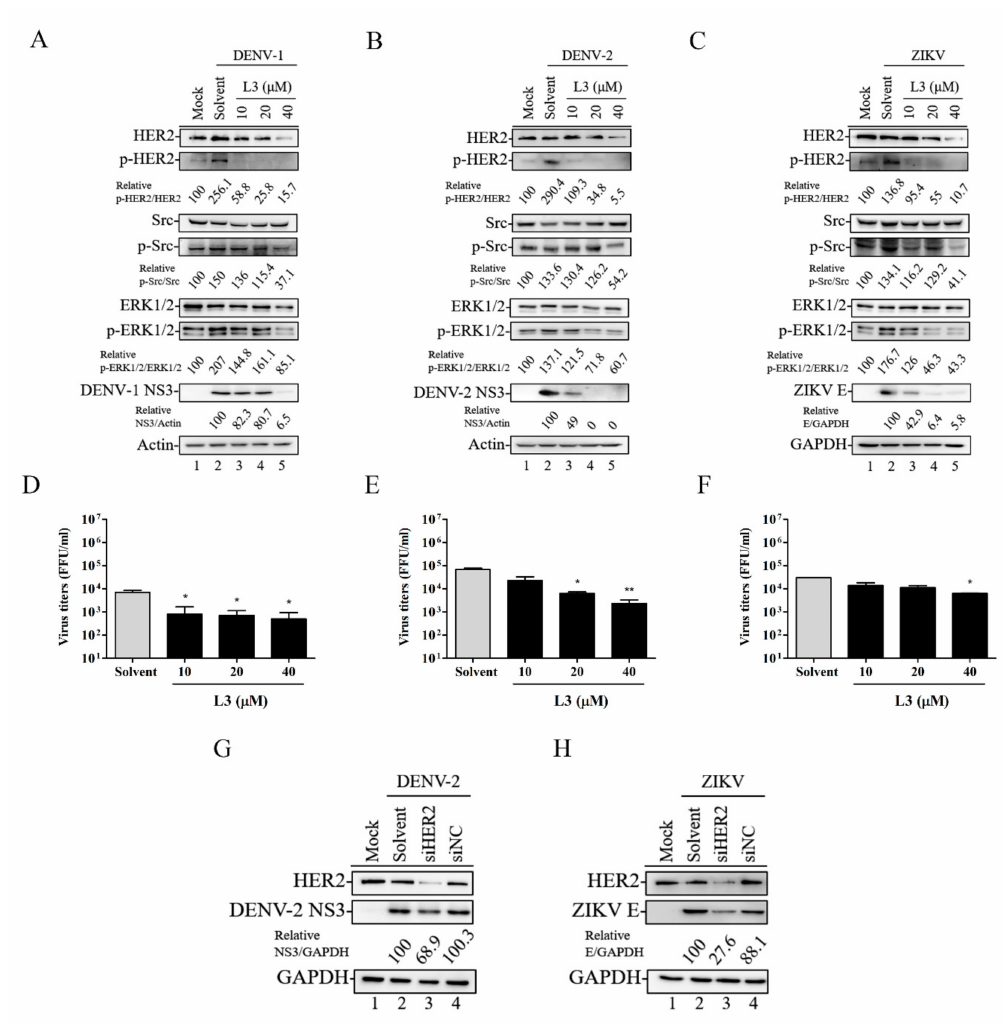
Figure 4. Compound L3 suppressed DENV and ZIKV replication through the HER2 signaling pathway. ( A – C ) MCF-7 cells were infected with DENV-1 for 36 h ( A ), DENV-2 for 30 h ( B ), or ZIKV for 36 h ( C ) (MOI = 1) and treated with 10, 20, or 40 µ M of compound L3 to monitor the phosphorylation of HER2, Src, and ERK1 / 2 signaling molecules by Western blotting. Relative ratios of p -HER2, p -Src, and p -ERK1 / 2 levels to HER2, Src, and ERK1 / 2 levels were adjusted to those of the mock control. Viral protein levels were also determined by Western blot analysis. The relative ratios of viral NS3 or E protein levels to actin or GAPDH levels were adjusted to those of the solvent control. Actin or GAPDH was used as the loading control. ( D – F ) Viral titers in culture supernatants were measured by a focus-forming assay. Data are the mean ± SD of three independent experiments. * p < 0.05, ** p < 0.01 by a two-tailed Student’s t -test. ( G , H ) MCF-7 cells were transiently transfected with an siRNA-HER2 (siHER2) or an siRNA negative control (siNC). At 24 h after transfection, the cells were infected with DENV-2 ( G